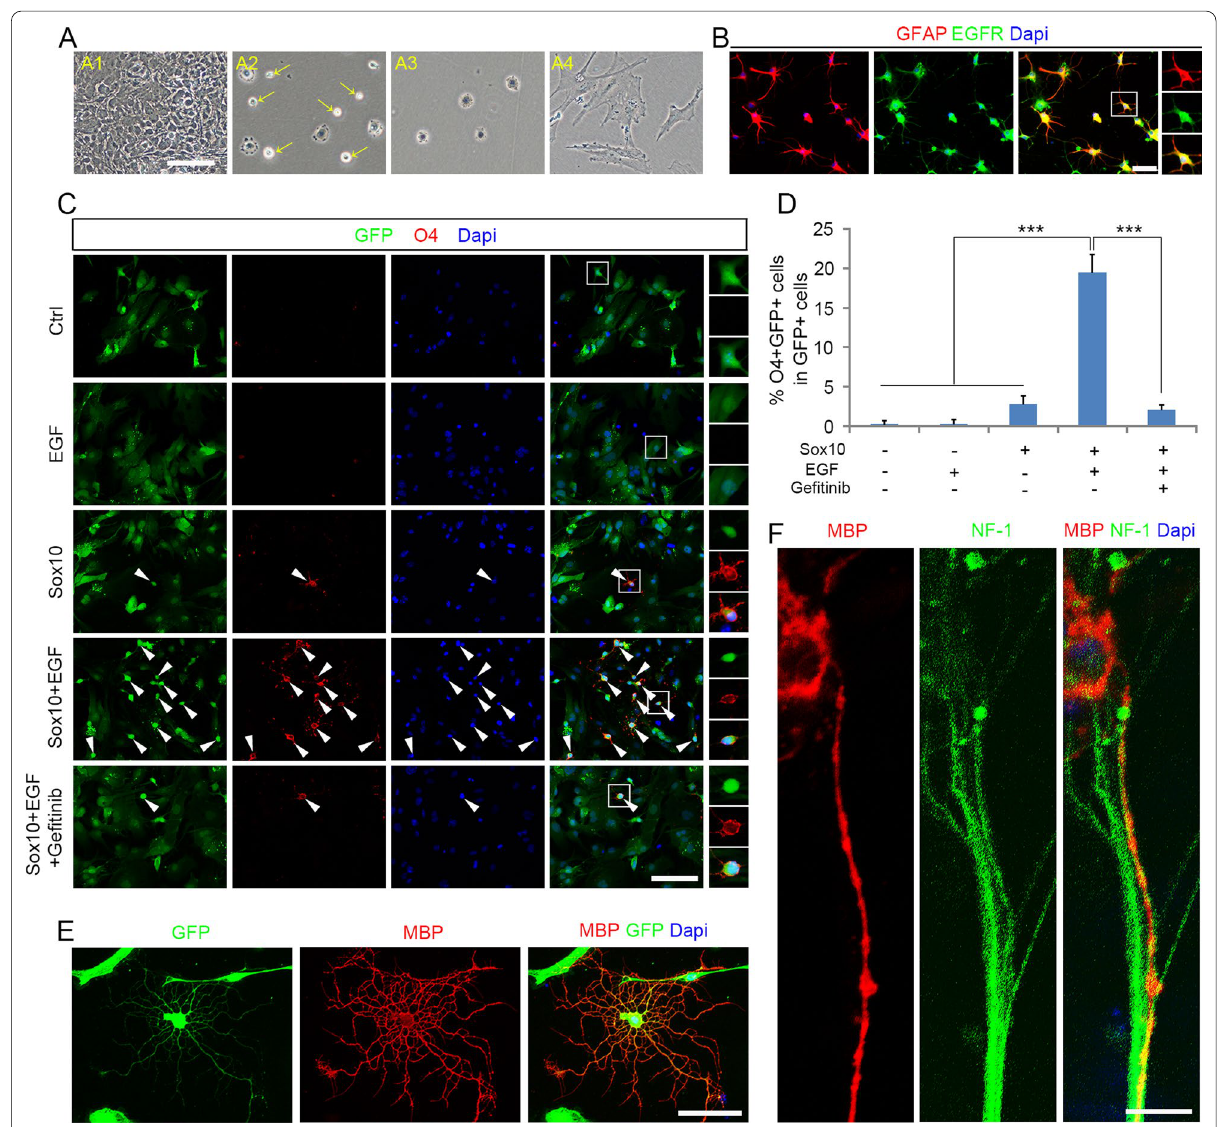
Fig. 1 Sox10 and EGF act synergistically to transdifferentiate astrocytes into iOPCs. A Representative images of astrocyte purifying. (A1) Primary glial culture of mouse spinal cord tissue. (A2) The cells shown in A1 were passaged to uncoated dishes and cultured for 30 min, astrocytes quickly adhered to the surface of dishes, while other cells were still floating (yellow arrows). (A3) The floating cells were rinsed and astrocytes were retained. (A4) Astrocyte morphology 24 h after purification. B Purified cells were immunoreactive to GFAP and EGFR antibodies. C Representative images of the astrocyte transdifferentiation (15 dpi) in the five cultures. D Quantifications of experiments presented in C . E MBP + mature OLs derived from iOPCs when cultured in the differentiation medium. F Confocal image of myelinated axon in iOPC/DRG co-culture. Purified iOPCs matured into MBP + OLs in the co-culture, and aligned with axons marked by neurofilament (NF-1) staining. Statistical analyses are presented as Mean ***P < 0.001. Scale bars, A – C 50 μm; E 25 μm; F 10